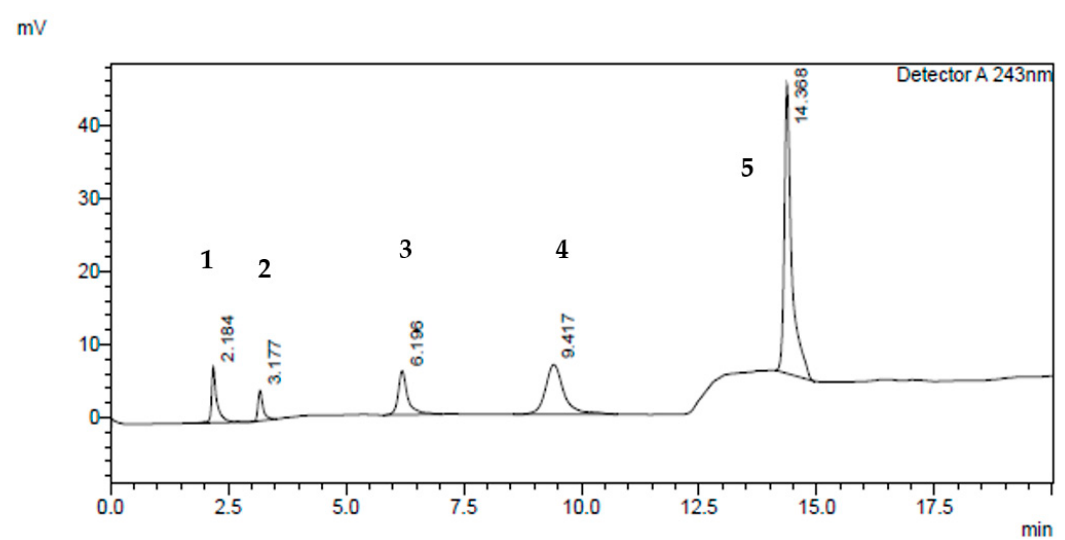
Figure 2. Typical HPLC chromatogram of UGT2B17 components at 243 nm using gradient elution programming. The peaks marked are: ( 1 ) UGT2B17 enzyme (Rt = 2.184 min); ( 2 ) salicylic acid (100 μ M) (Rt = 3.177 min); ( 3 ) phenacetin (50 μ M) (Rt = 6.196 min); ( 4 ) testosterone glucuronide (100 μ M) (Rt = 9.417 min); and ( 5 ) testosterone (200 μ M) (Rt = 14.388 min), respectively.